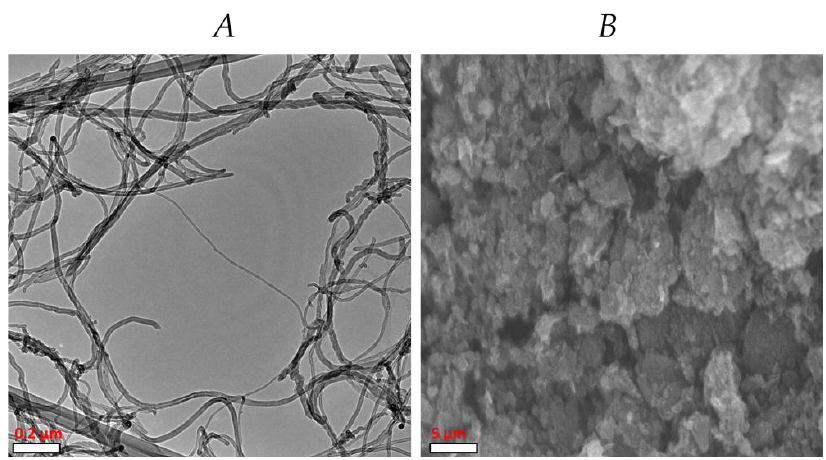
Figure 7. Carbon nanotubes ( A ) and graphene ( B ) obtained by scanning electron microscopy.